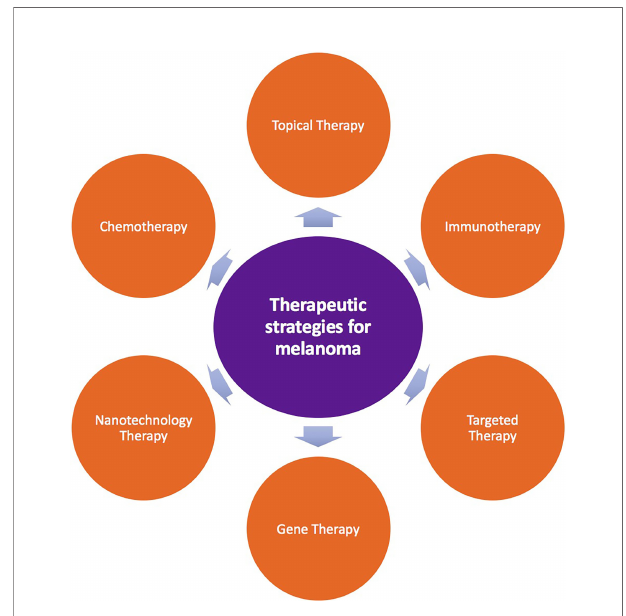
FIGURE 1 | Therapeutic strategies for